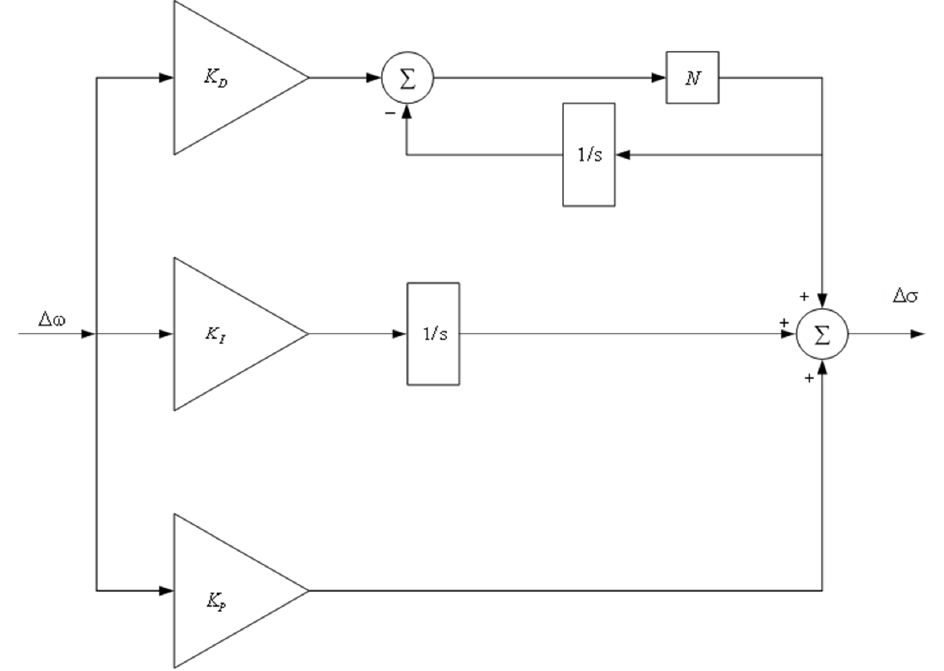
Figure 3. Block diagram of the PIDF controller. A block diagram of the TCSC PIDF controller with a speed deviation in the SMIB system is shown in Figure 4.